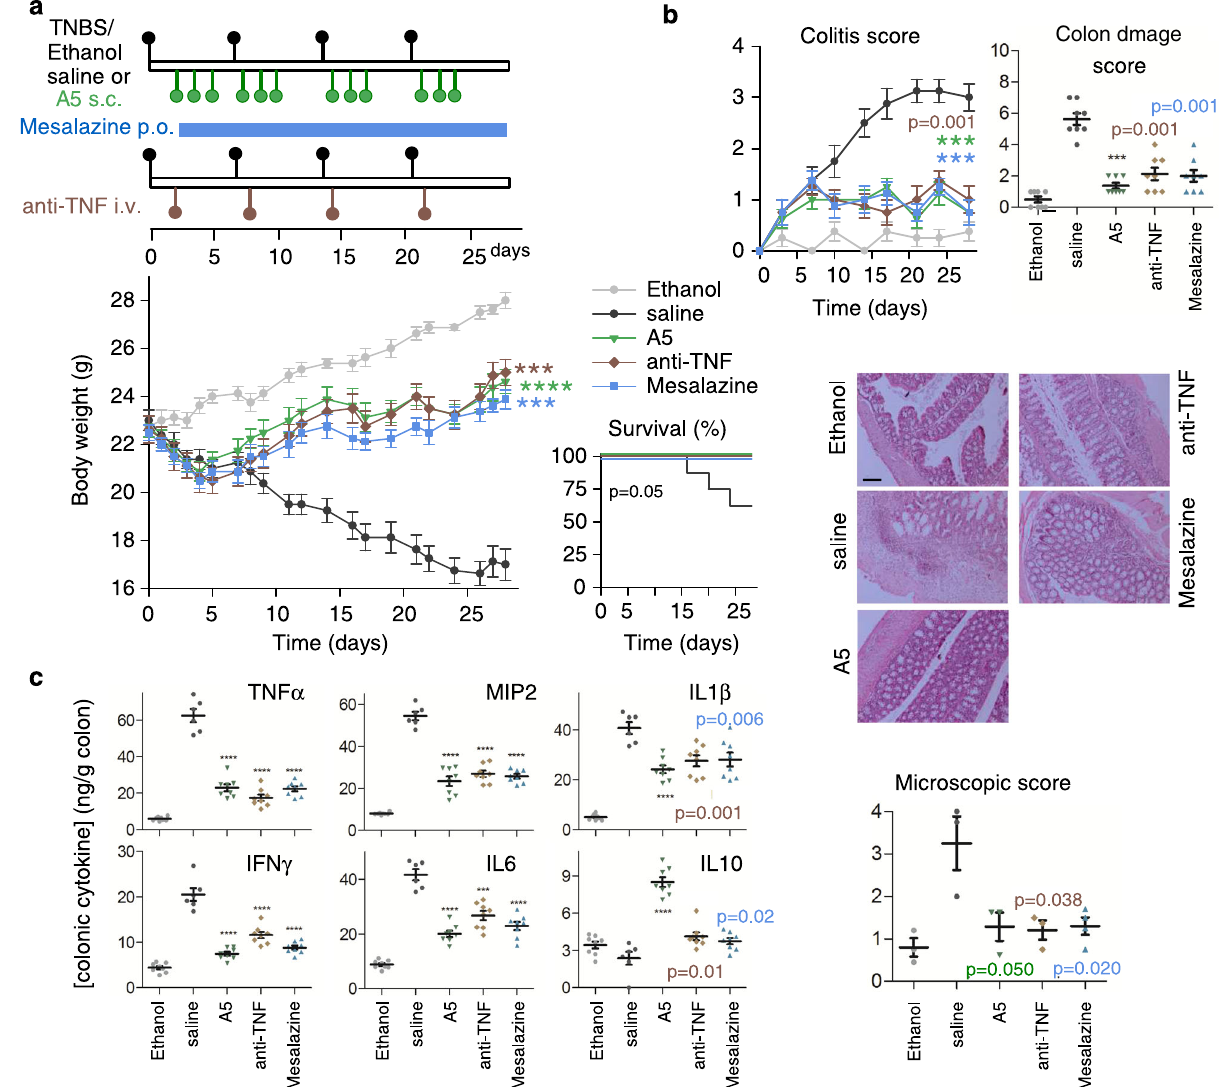
Fig. 5 Therapeutic effects of analogue 5 on TNBS-induced chronic colitis. Chronic colitis was induced in mice by intrarectal injections of increasing doses of TNBS once a week and animals were then repetitively treated with analogue 5 (A5), anti-mouse TNF α antibody or mesalazine as indicated in the scheme ( a ). Mice injected with 50% ethanol were used as basal controls. Animals injected with saline instead of A5 were used as untreated colitic mice. Disease evolution and severity were monitored by survival and weight loss, colitis score, macroscopic colon damage score and histopathological signs ( b ) and by measuring the cytokine concentration levels in colonic mucosa ( c ). n = 8 mice/group in all assays, unless for histopathological analysis ( n = 3 – 4 mice/ group, where representative images are shown at ×100 magni fi cation, scale bar: 200 µ m). Data are mean ± SEM with dots representing individual values of biologically independent animals. Statistical differences between groups were calculated using two-tailed non-parametric Mann – Whitney test (for colon damage, colitis and microscopic scores), unpaired two-tailed Student ’ s t test (for body weight, colon length and weight, and colonic cytokines) and Kaplan – Meier test (for survival). *** p < 0.001; **** p < 0.0001 versus untreated TNBS-colitic mice (saline). Exact p -values are shown for p > 0.001. Source data are provided as a Source Data fi le. s.c. subcutaneous, i.v. intravenous, p.o.